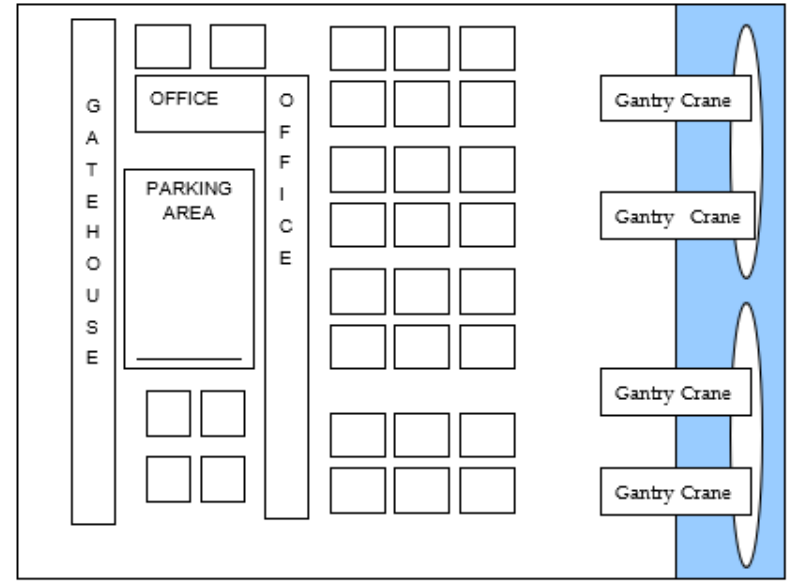
Figure 2. A Layout of a Container Terminal Port.